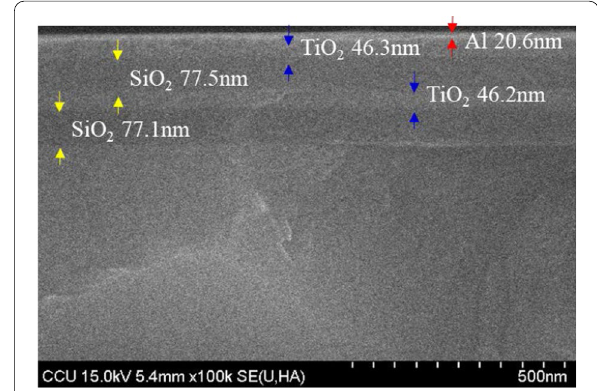
Fig. 8 Cross‑sectional SEM image of the HRTF